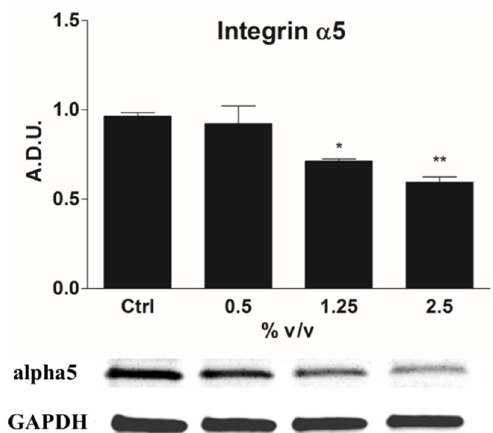
Figure 7. Western blot of integrin α 5. Bar graph shows the relative expression of the respective protein level. Representative immunoblotting image of integrin α 5 expression. All values are mean ± SD of three experiments in triplicate. * p < 0.05; ** p < 0.01 vs. control.